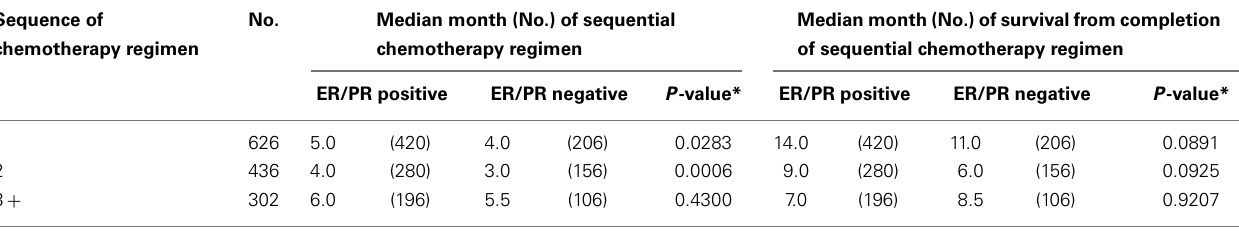
ER/PR, estrogen receptor and/or progesterone receptor.